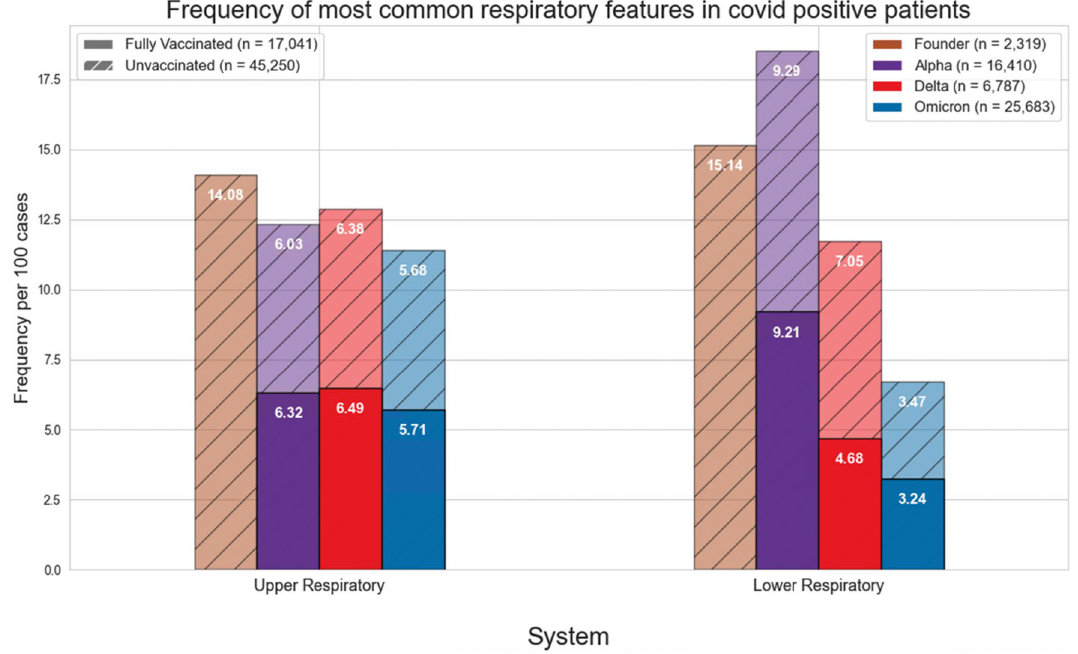
Figure 1. Comparison of frequency of most common respiratory features in COVID positive patients based on fully vaccinated or unvaccinated